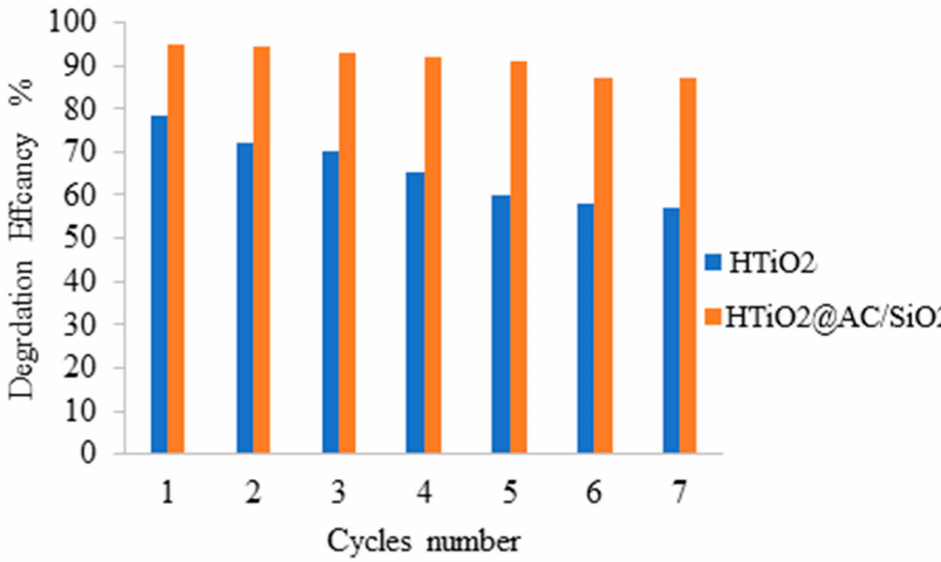
Figure 12. Chlorpyrifos degradation by using the produced photocatalysts